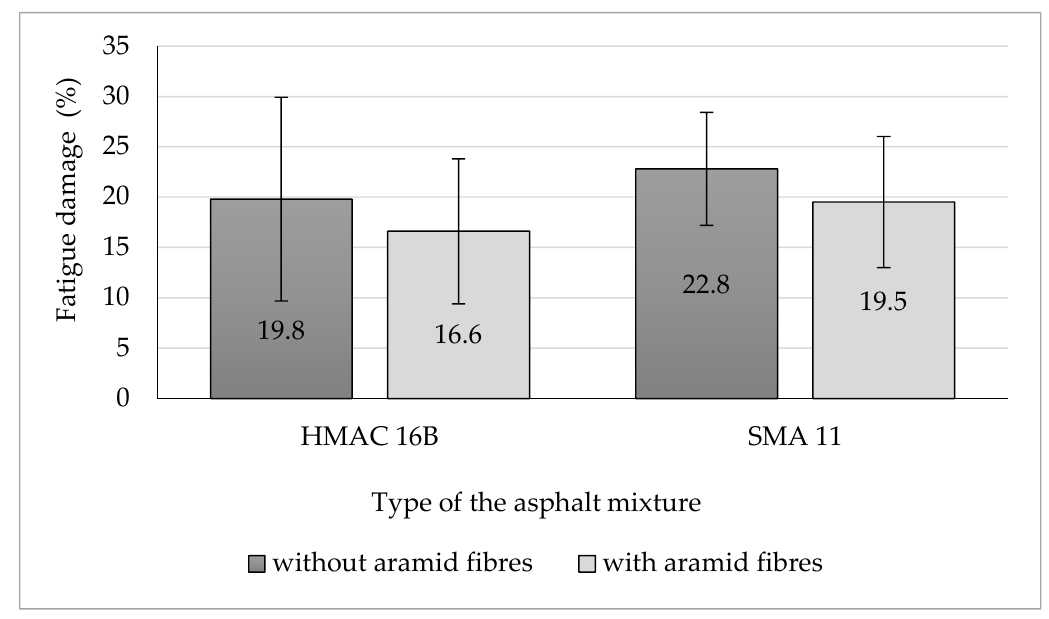
Figure 10. Fatigue damage of analysed asphalt mixtures.